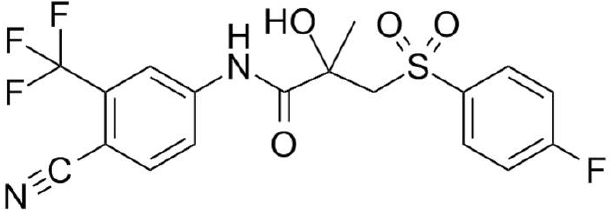
Figure 1. Molecular structure of